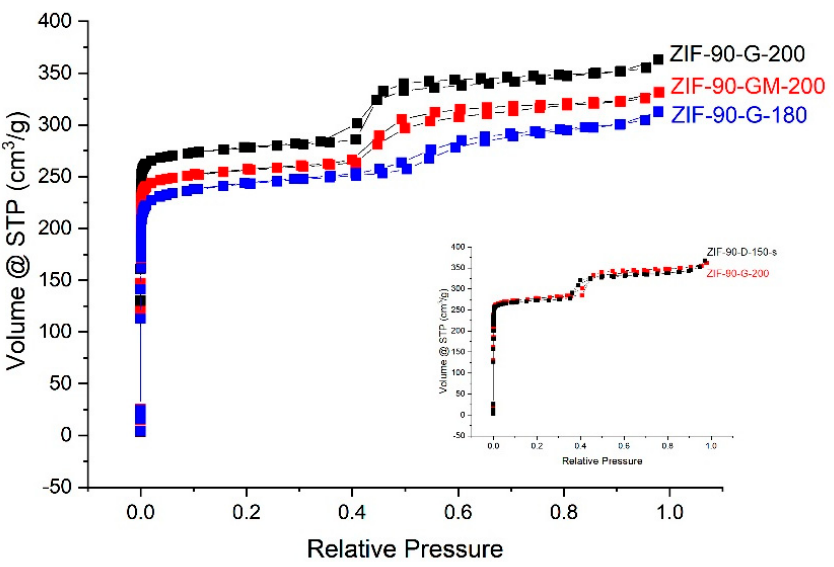
Figure 4. PXRD of ZIF-90-G and ZIF-90-GM before and after thermal burst activation at 200 °C.